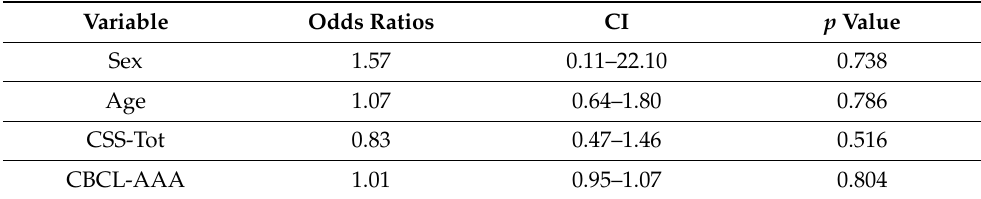
Table 3. Results of a binomial regression analysis testing patient sex, age, severity of ASD (CSS-Tot) and of emotional dysregulation (CBCL-AAA) as factors influencing the successful completion of EEG ( n = 45)